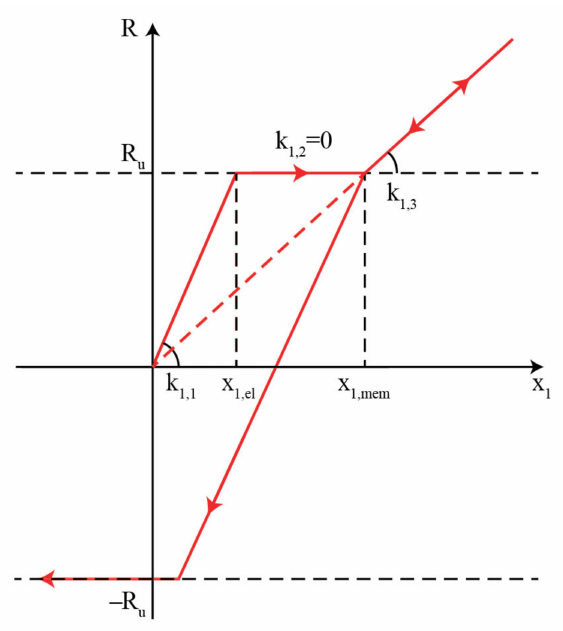
Figure 2. Force–displacement diagram of cladding with both bending and membrane